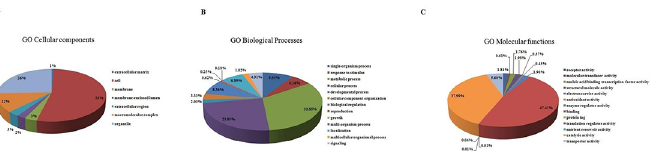
Fig 3. Gene Ontology (GO: level 2) categorization of whitefly unitigs. Sequences were categorized into (A) cellular component, (B) biological process and (C) molecular function on the basis of similarity.